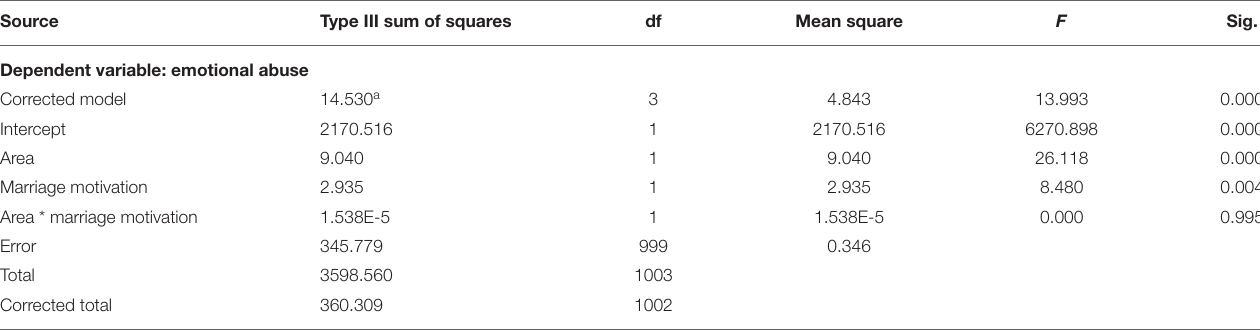
TABLE 7 | Tests of between-subjects effects.